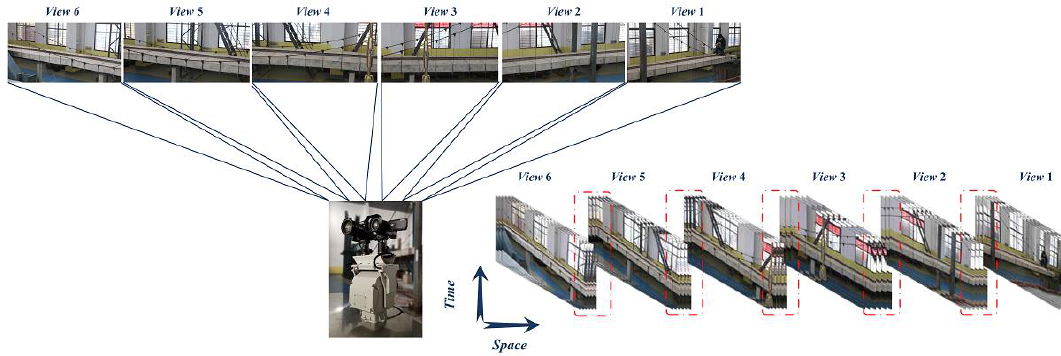
Figure 5. The measured spatial and temporal series data.